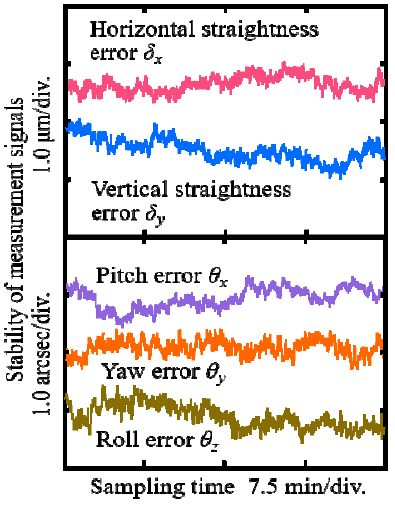
Figure 6. Stability of the measurement signals when the beam drift compensation unit (BDCU) was activated.